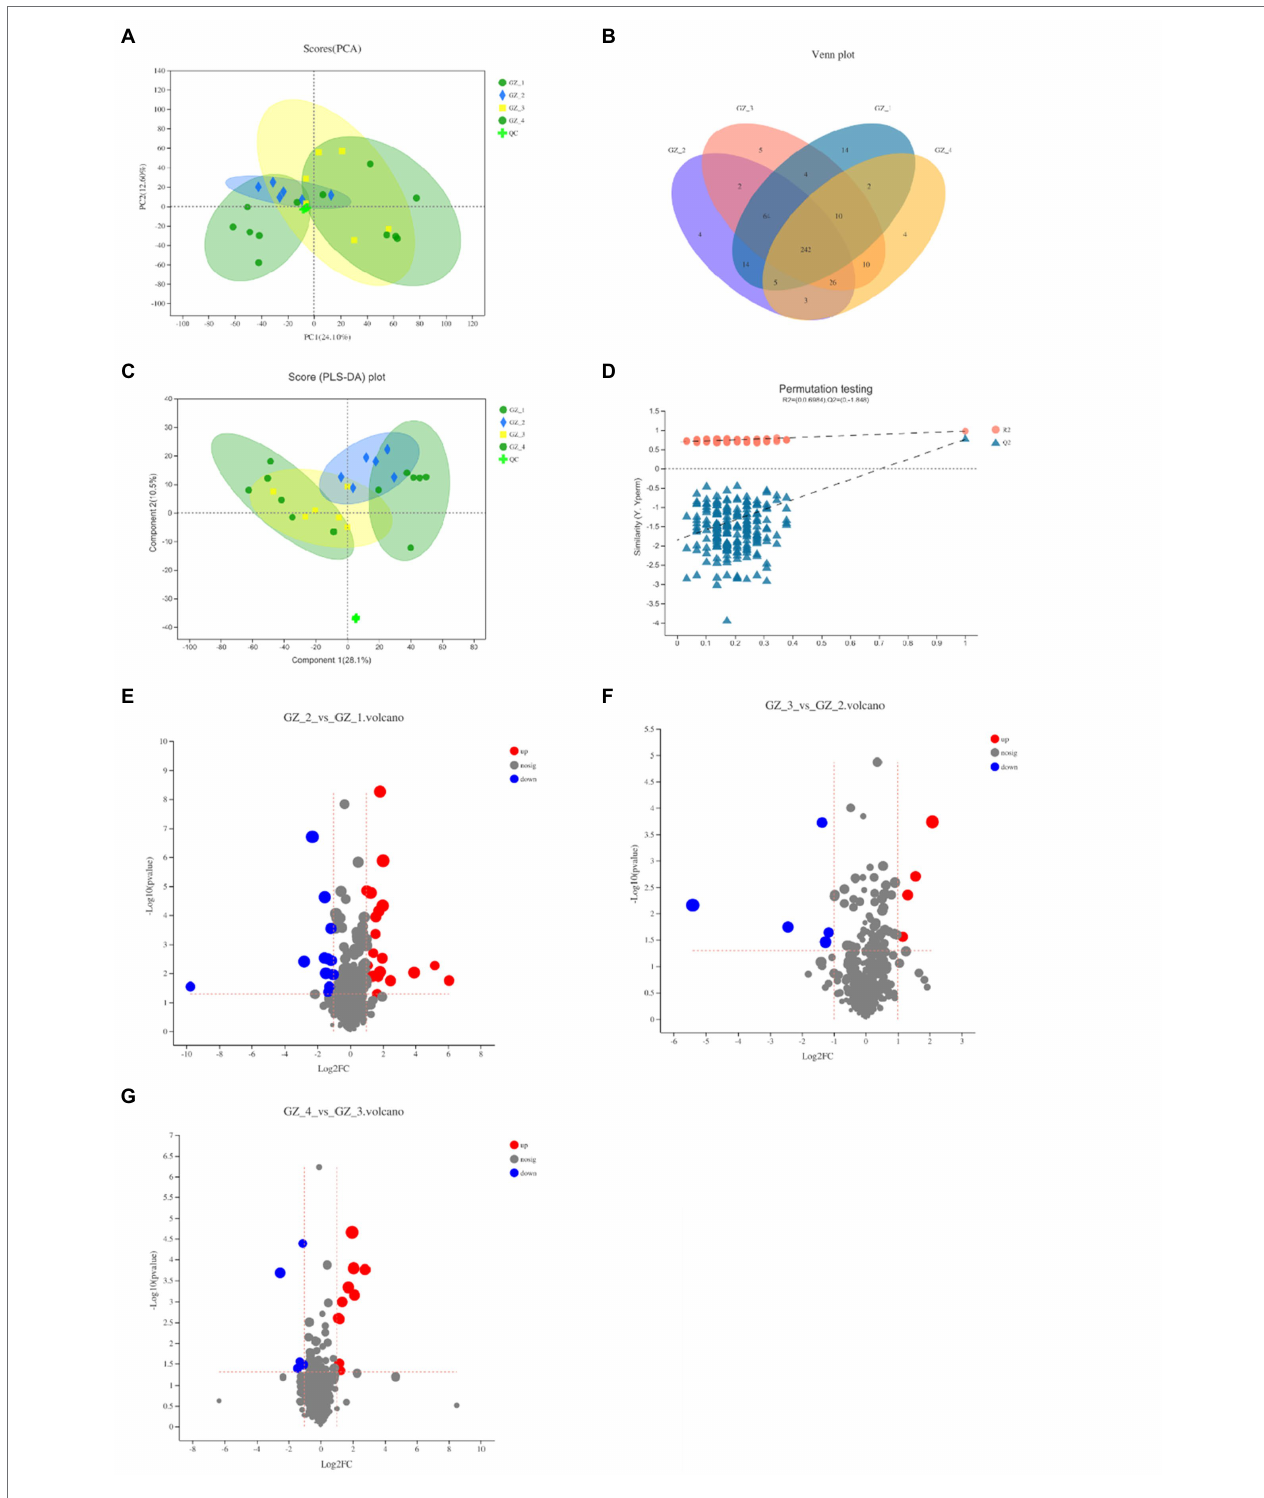
FIGURE 4 | Changes of metabolites of licorice during the four periods of natural drying process (GZ_1: fresh licorice; GZ_2: early drying-6 days after drying; GZ_3: mid-drying-12 days after drying; and GZ_4: completely dried-18 days after drying. Each sample was made by mixing five licorice roots, and the measurement was repeated six times). (A) Different periods of cationic PCA scores. (B) Venn diagram of metabolites in different periods. (C) PLS-DA score chart of different periods. (D) PLS-DA model verification. (E) Fresh licorice and early drying licorice metabolites’ volcano graph. (F) Volcano map of different metabolites of licorice in the early and mid-drying period. (G) Volcano map of the different metabolites of licorice in the mid-drying period and completely